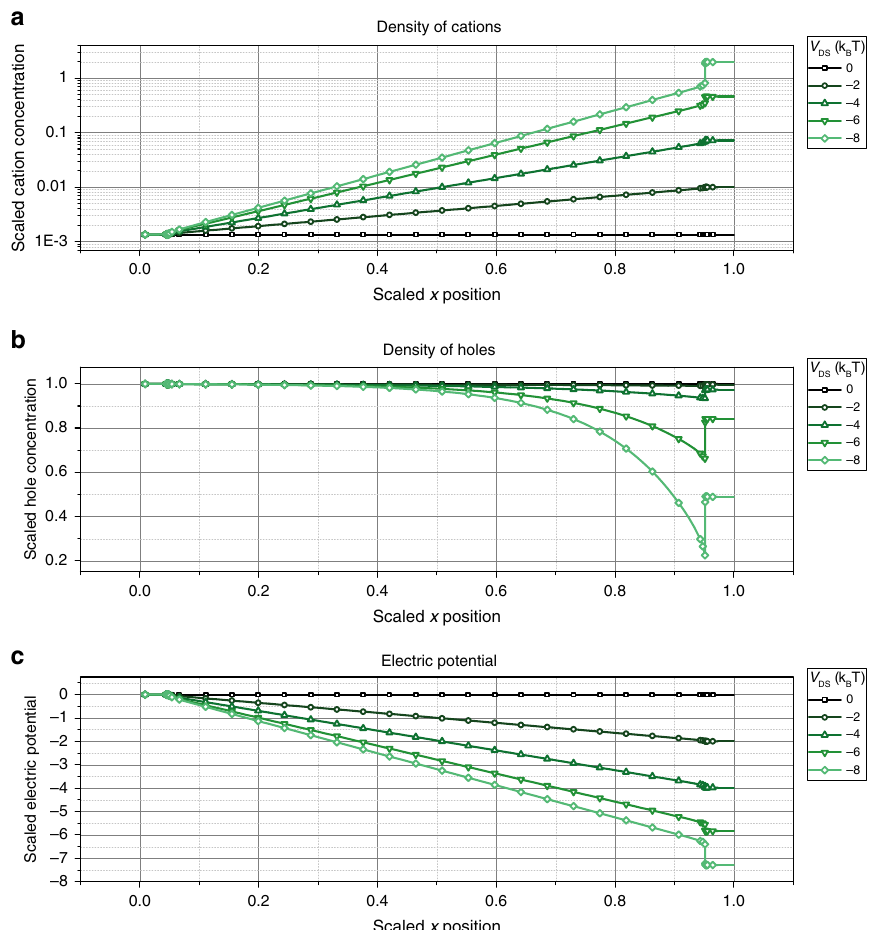
Fig. 7 Equilibrium state of the transistor channel. a Density of cations p ion ( x , y = 0), b holes p ( x , y = 0), and c electric potential Φ ( x , y = 0) along the channel of the simulated OECT shown in Fig. 6 at V GS = − 2 V T . The parameters used for the simulation are summarized in Supplementary Table 1. Concentrations are scaled to the doping concentration in the PEDOT:PSS layer p 0 = 10 20 cm − 3 , spatial coordinates are scaled by the channel length of the device L 0 = 1.13 μ m, and the potential is scaled by the thermal voltage V T = k B T / e .